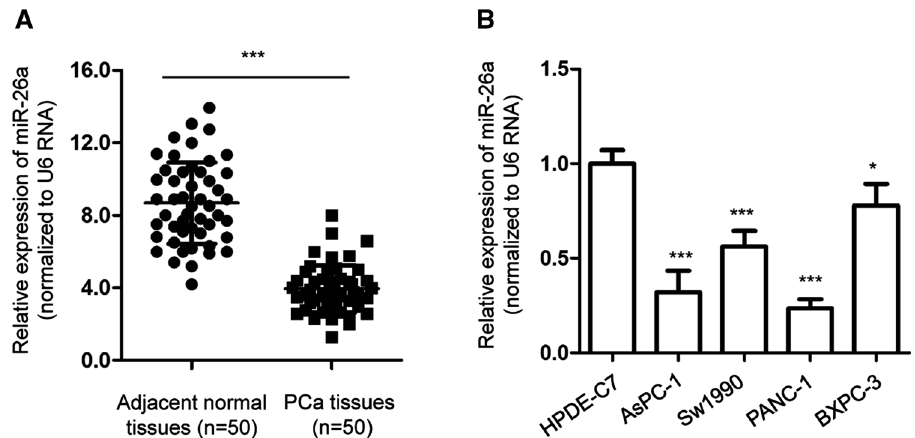
Fig. 1 miR-26a expression was down-regulated in PCa. A A comparison of miR-26a expression in 50 paired PCa tissues and adjacent non-can- cer tissues. B miR-26a levels in normal HPDE-C7 cell and PCa cell lines. Sw1990, PANC-1, AsPC-1, and BXPC-3. * P < 0.05; *** P <